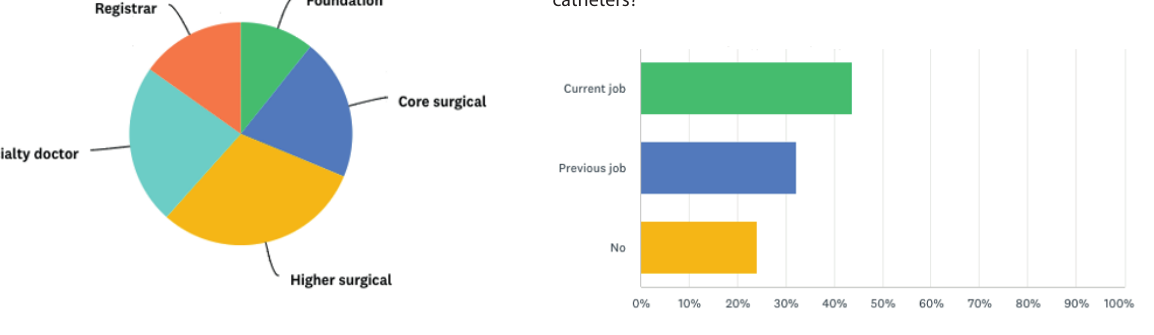
Figure 2. ‘What is your level of training?’